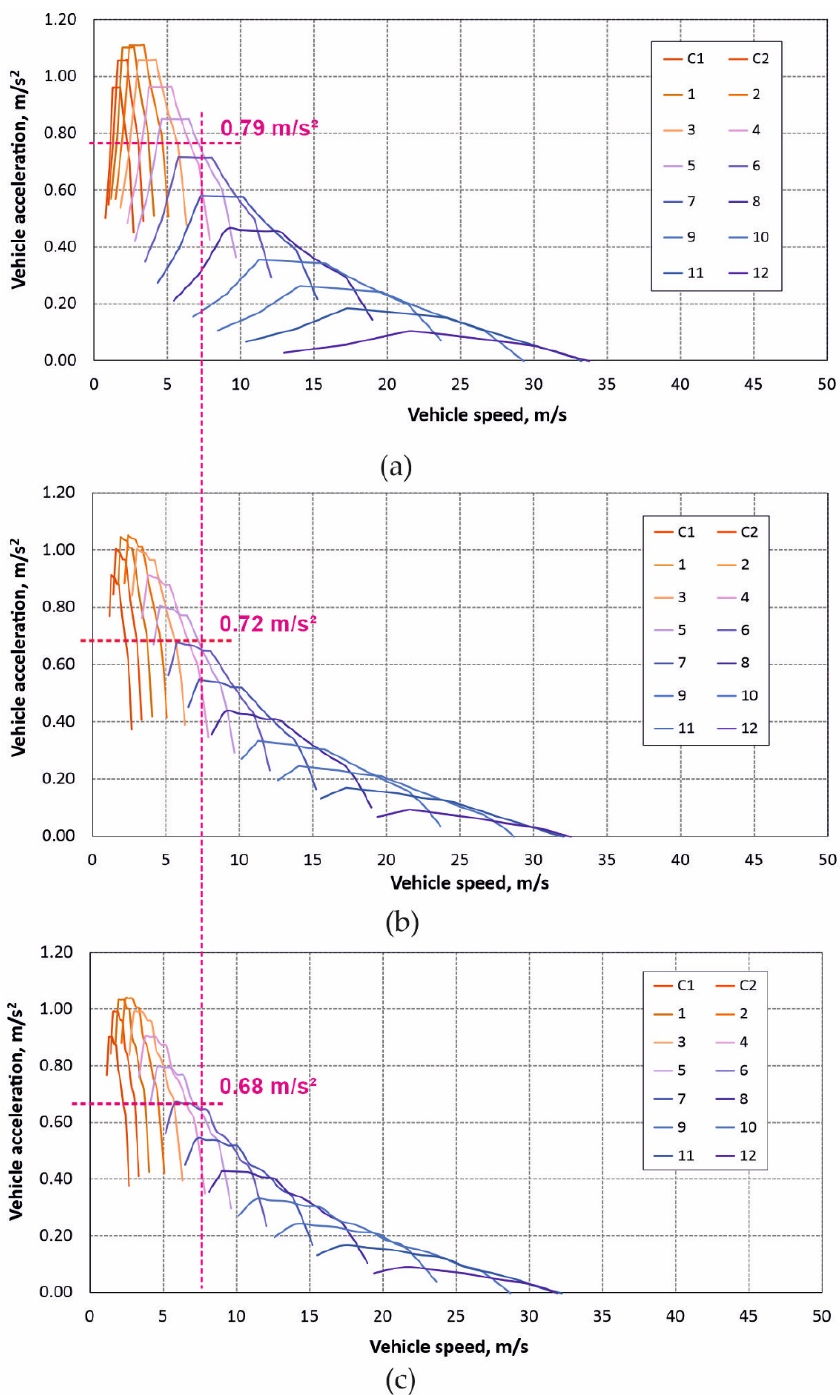
Figure 11. Acceleration achieved in individual gears. ( a ) Factory data, ( b ) Diesel and ( c ) Diesel/CNG.